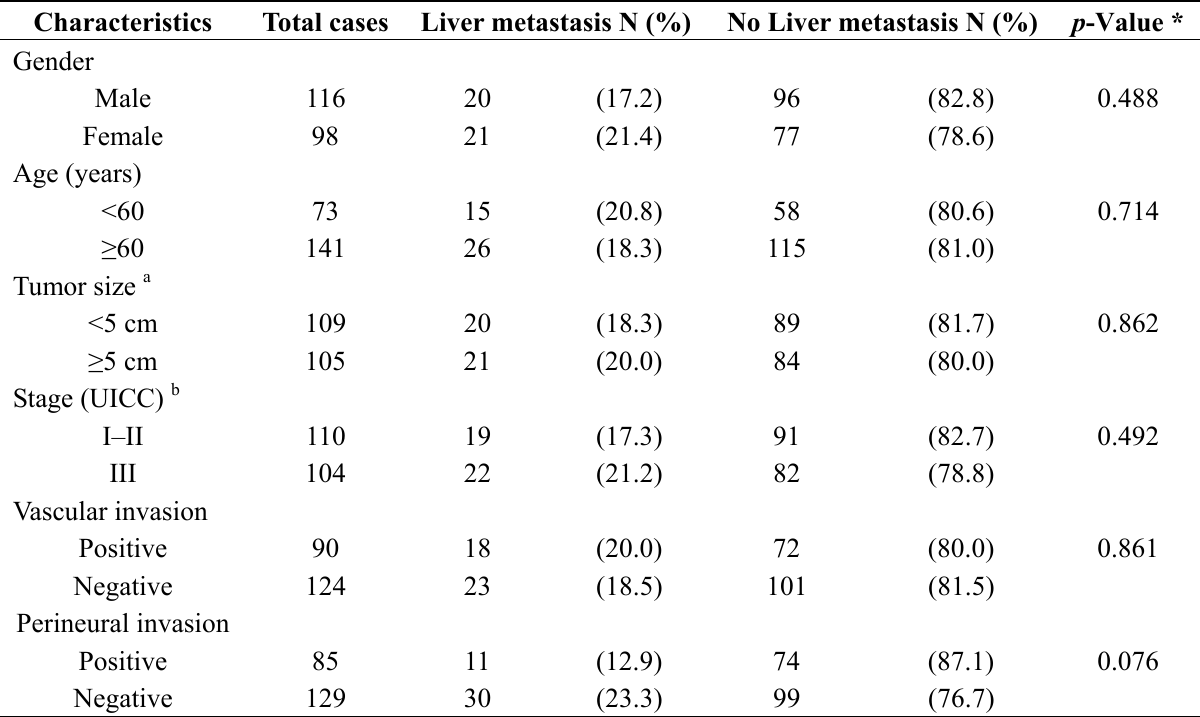
Table 2. Correlations between clinicopathological features and liver metastatic status for 214 postoperative colorectal cancer